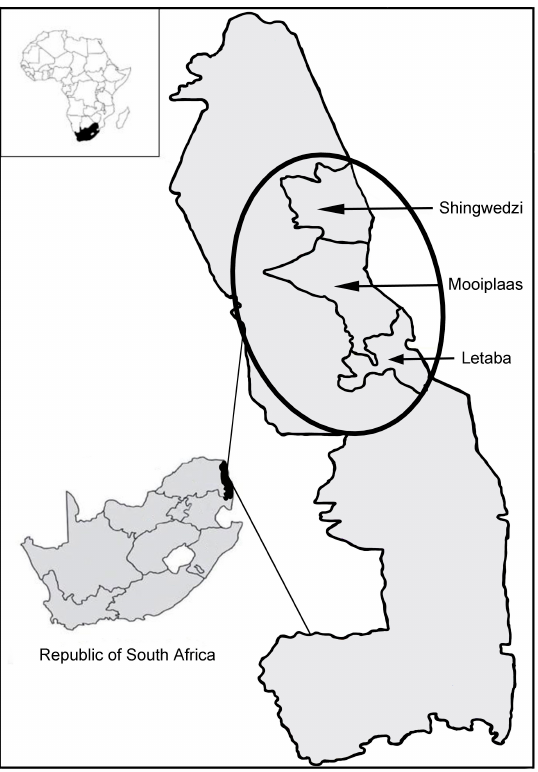
Figure 1. A map of Kruger National Park, South Africa. The encircled area represents the study area. Arrows indicate the sites where rainfall data were collected.